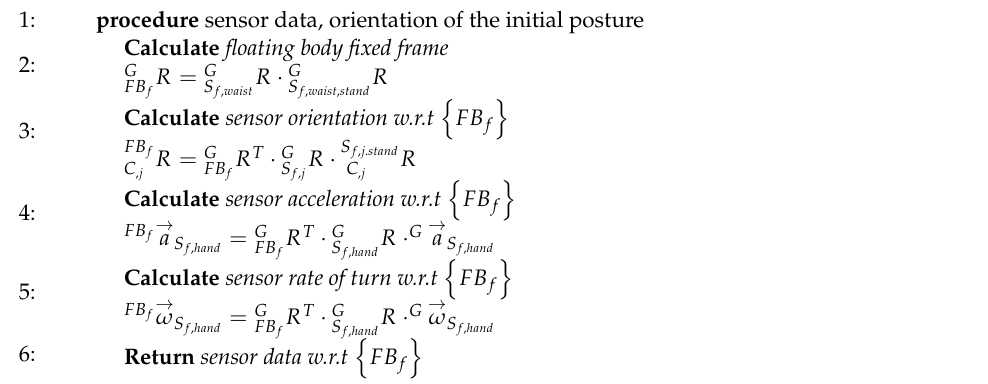
Algorithm 3 Updating the body-fixed frame according to change in subject’s time-varying body-alignment